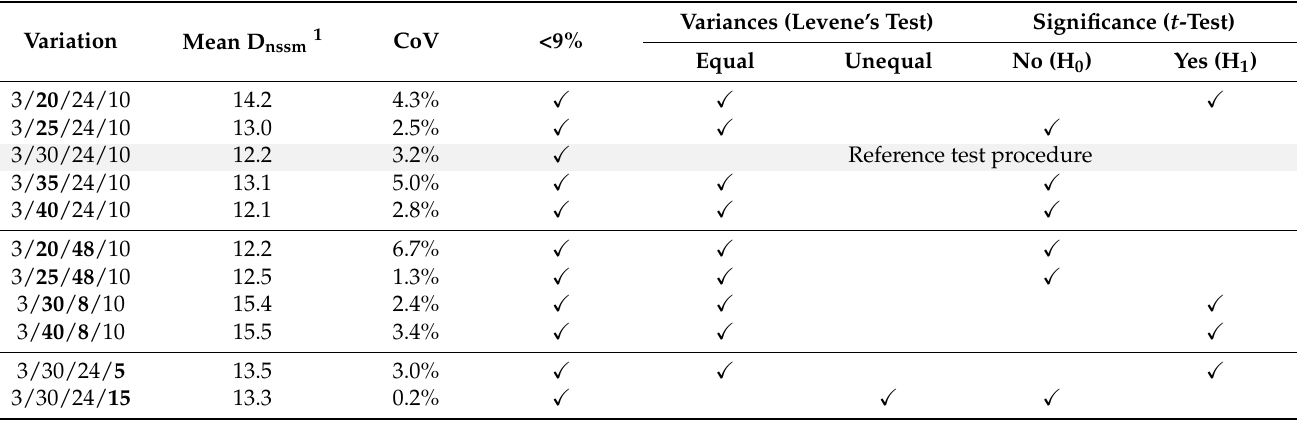
Table 6. Comparison of D nssm determined with variations in the applied voltage, the test duration and the concentration of NaCl in the solution in reference to